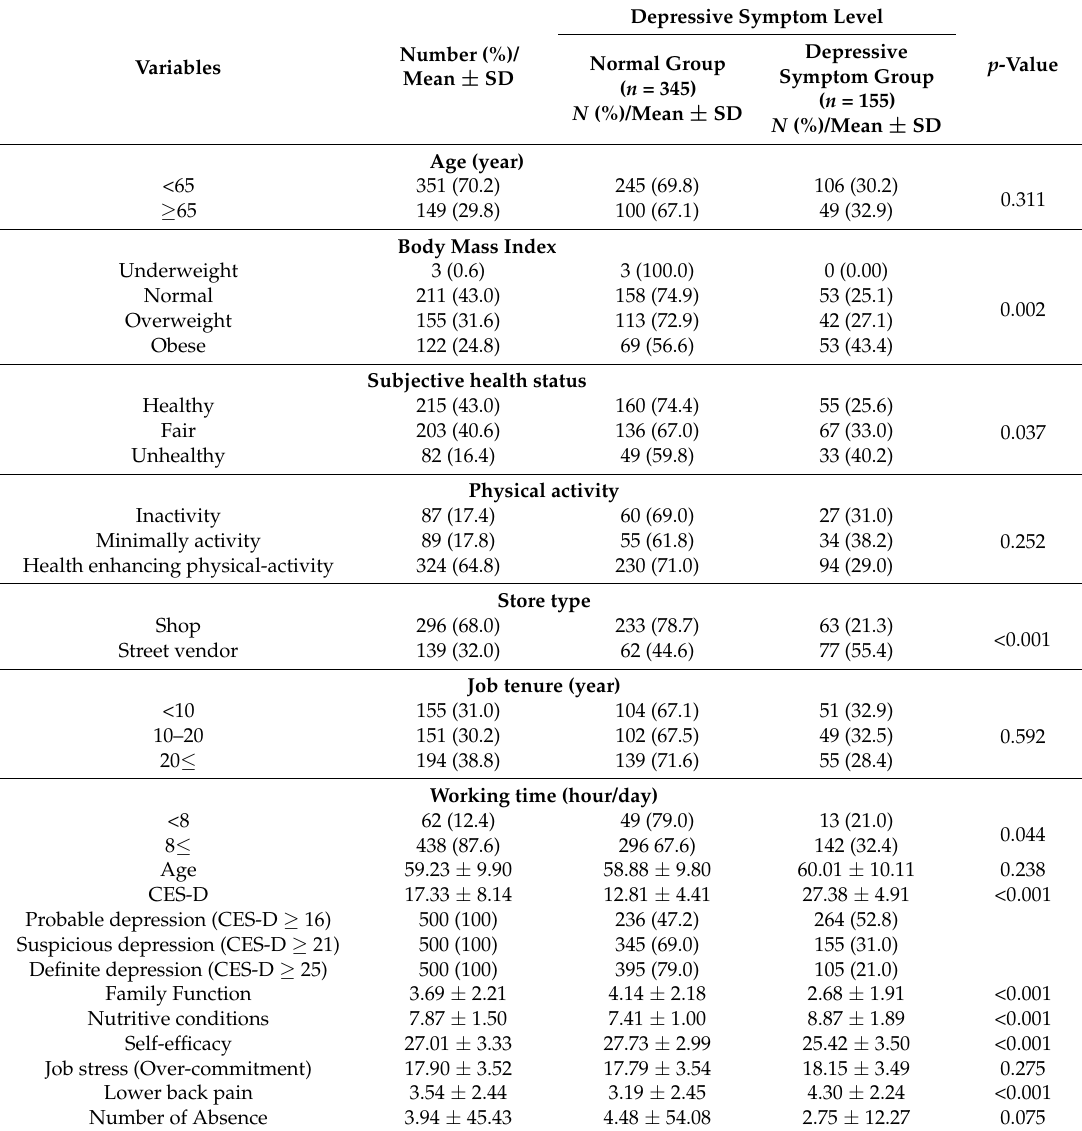
Table 1. Distribution of depressive symptom group according to socio-demographic and work related factors ( N =